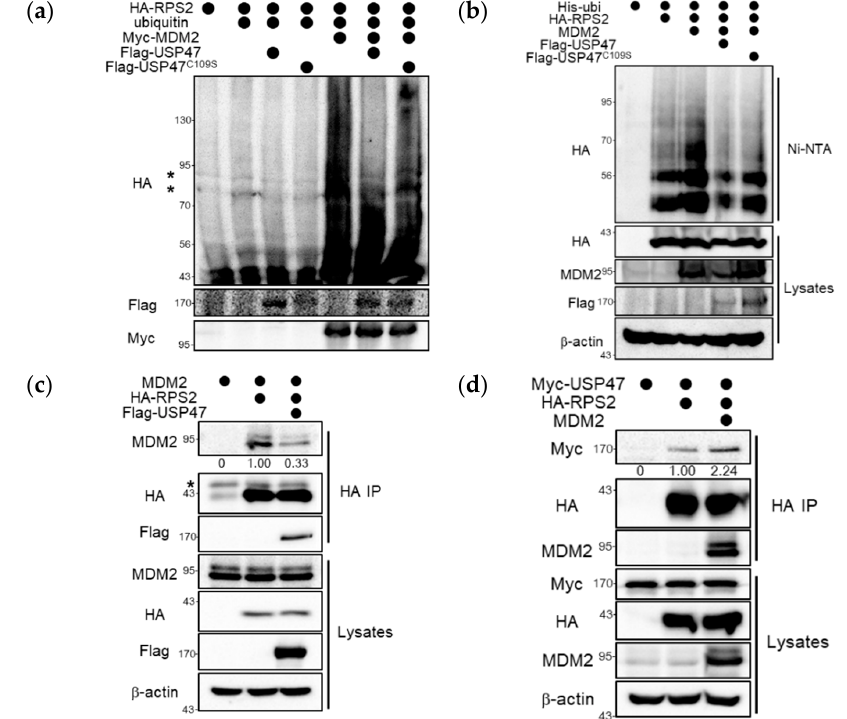
Figure 3. USP47 deubiquitinates RPS2 and regulates the interaction between RPS2 and MDM2. ( a ) HeLa cells were transfected with ubiquitin, HA-RPS2, Myc-MDM2, Flag-USP47, or Flag-USP47 C109S and then treated with MG132 (10 µ M) for 4 h. Cells were harvested and immunoblotted with the indicated antibodies. The non-specific band is denoted by an asterisk. ( b ) HEK293T cells were co-overexpressed with His-ubiquitin, HA-RPS2, MDM2, Flag-USP47, or Flag-USP47 C109S and then treated with MG132 (10 µ M) for 4 h. Ubiquitin conjugates were purified on Ni-NTA agarose under denaturing conditions, and ubiquitinated RPS2 was detected with the anti-HA antibody. ( c ) HEK293T cells were overexpressed with MDM2, HA-RPS2, and Flag-USP47, and then immunoprecipitation was performed with anti-HA agarose. Bound proteins were immunoblotted with the indicated antibodies. The non-specific band is denoted by an asterisk. ( d ) HEK293T cells were overexpressed with Myc-USP47, HA-RPS2, and MDM2, and then immunoprecipitation was performed with anti-